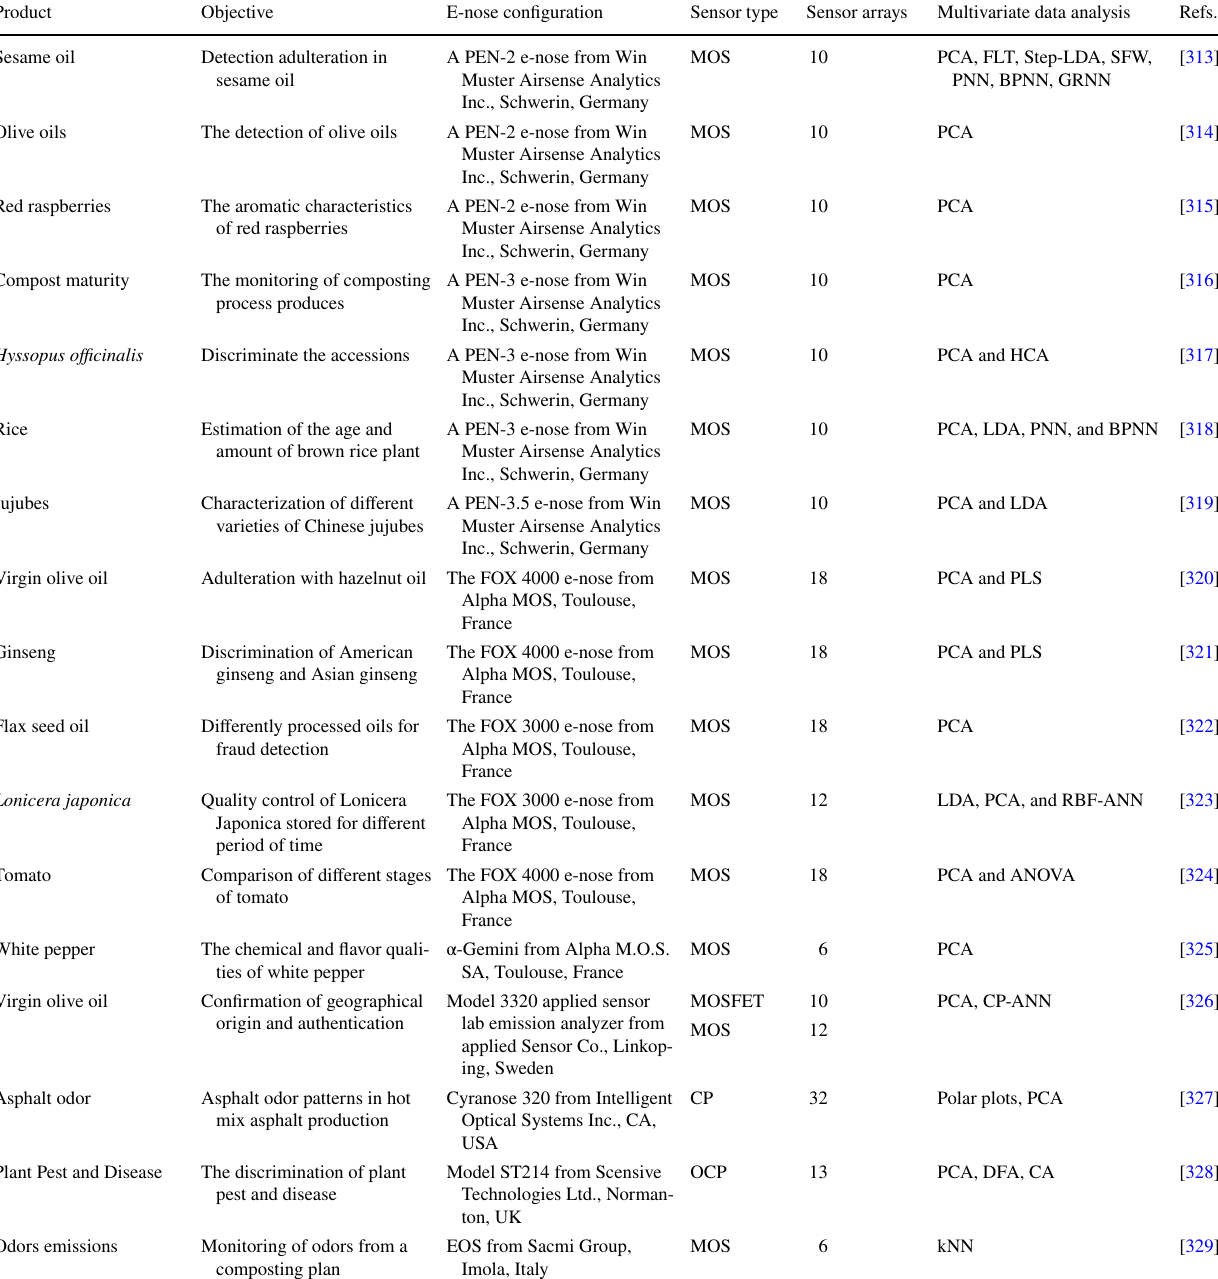
Table 11 Applications of electronic nose in agriculture